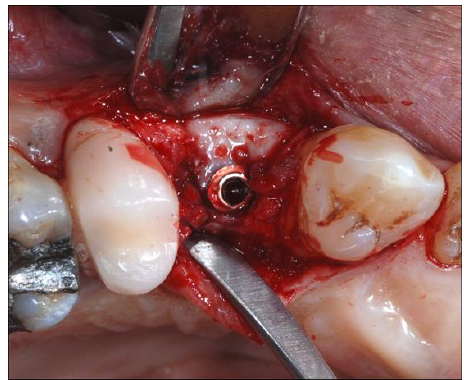
Figure 5. Occlusal view of the bone gain after 8 months from the augmentation surgery at the re-entry phase.